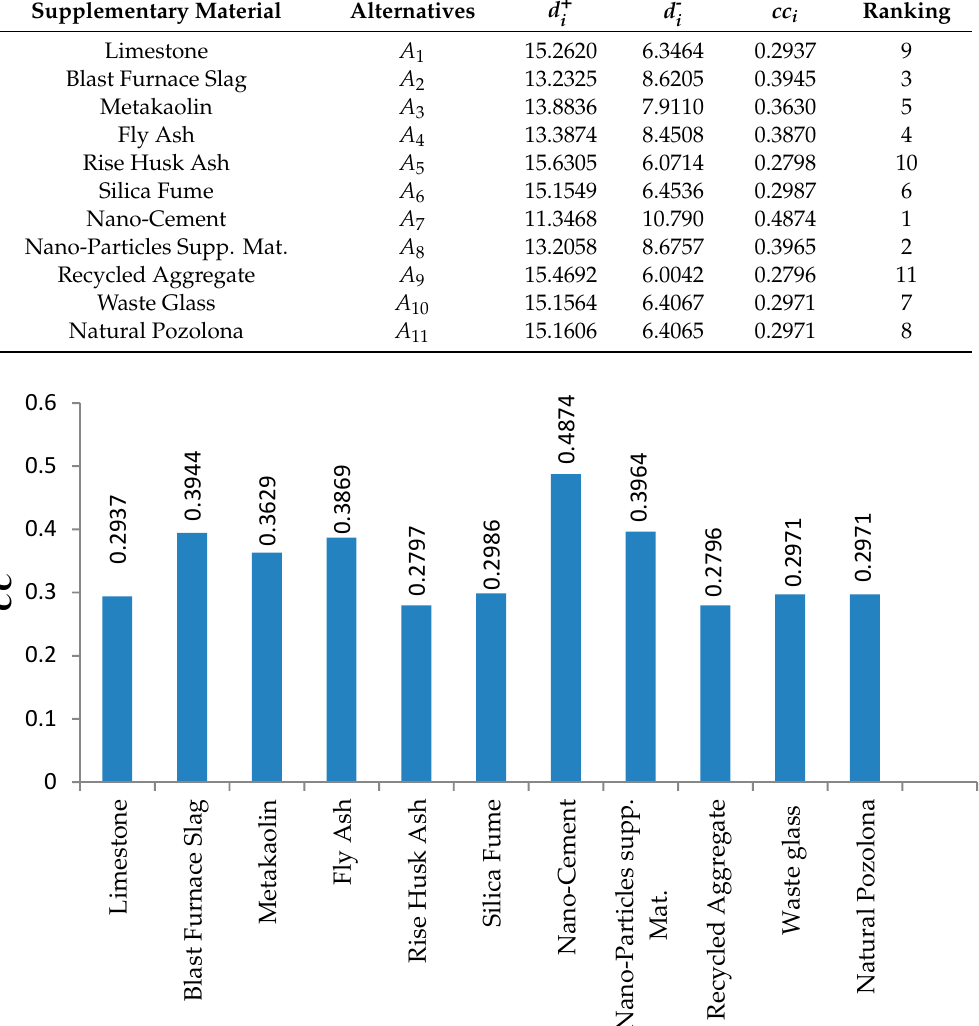
Table 6. The fuzzy positive ideal reference point (FPIRP) and fuzzy negative ideal reference point (FNIRP) distances, closeness coe ffi cients and rank of each sustainable siliceous materials.